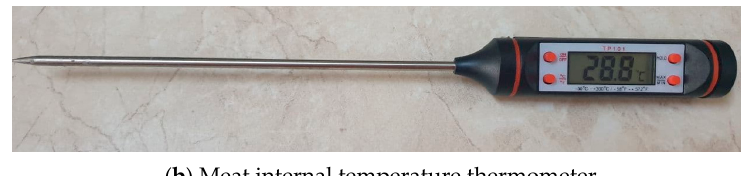
Figure 5. The lamb meat and thermometer.